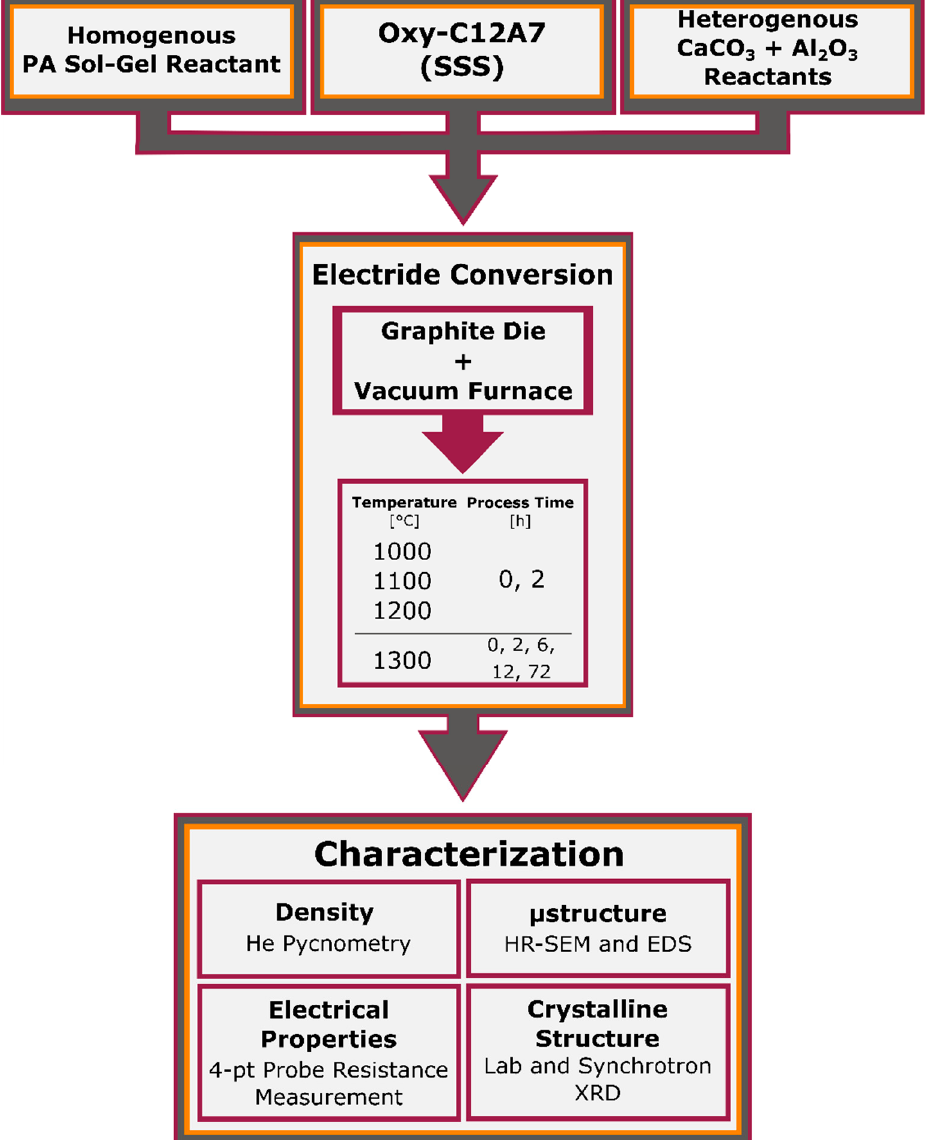
Figure 3. Experimental flow chart for the synthesis, consolidation, and electride formation, and characterization.